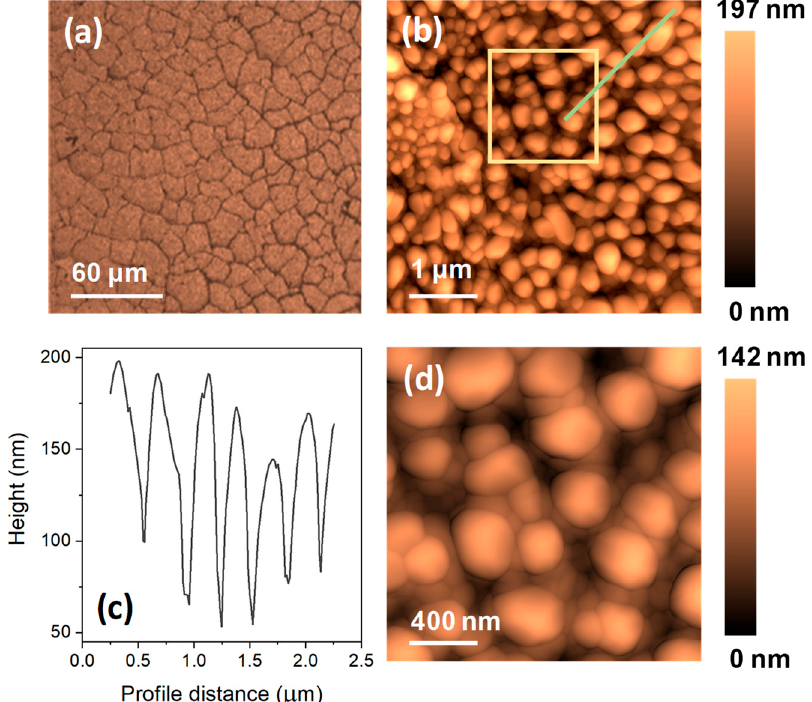
Figure 2. ( a ) Optical micrograph and ( b ) AFM image acquired from the surface of the nanoparticulated hematite coating. ( c ) Topographic profile distance of the green straight line in subfigure b. ( d ) Magnification of the yellow square area indicated in subfigure b. The optical image is displayed in false color. Color scales represent the height differences of the AFM images.